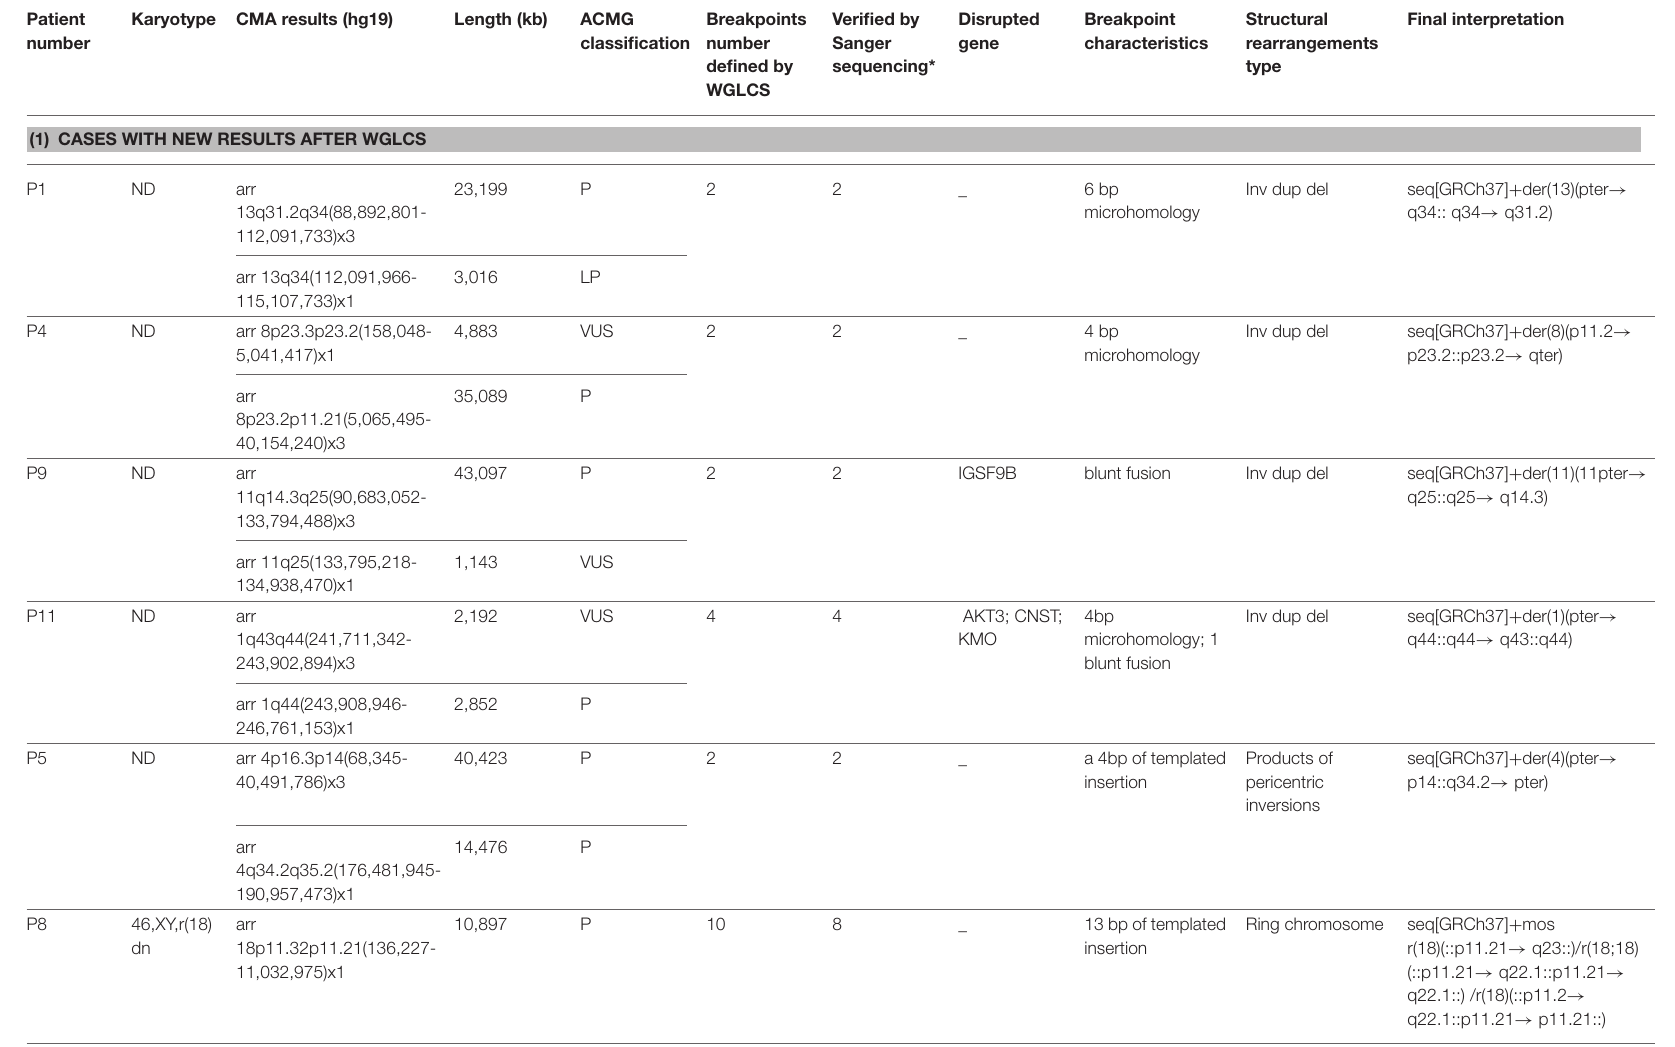
TABLE 1 | Breakpoint junction features of the structural rearrangements identified in 15